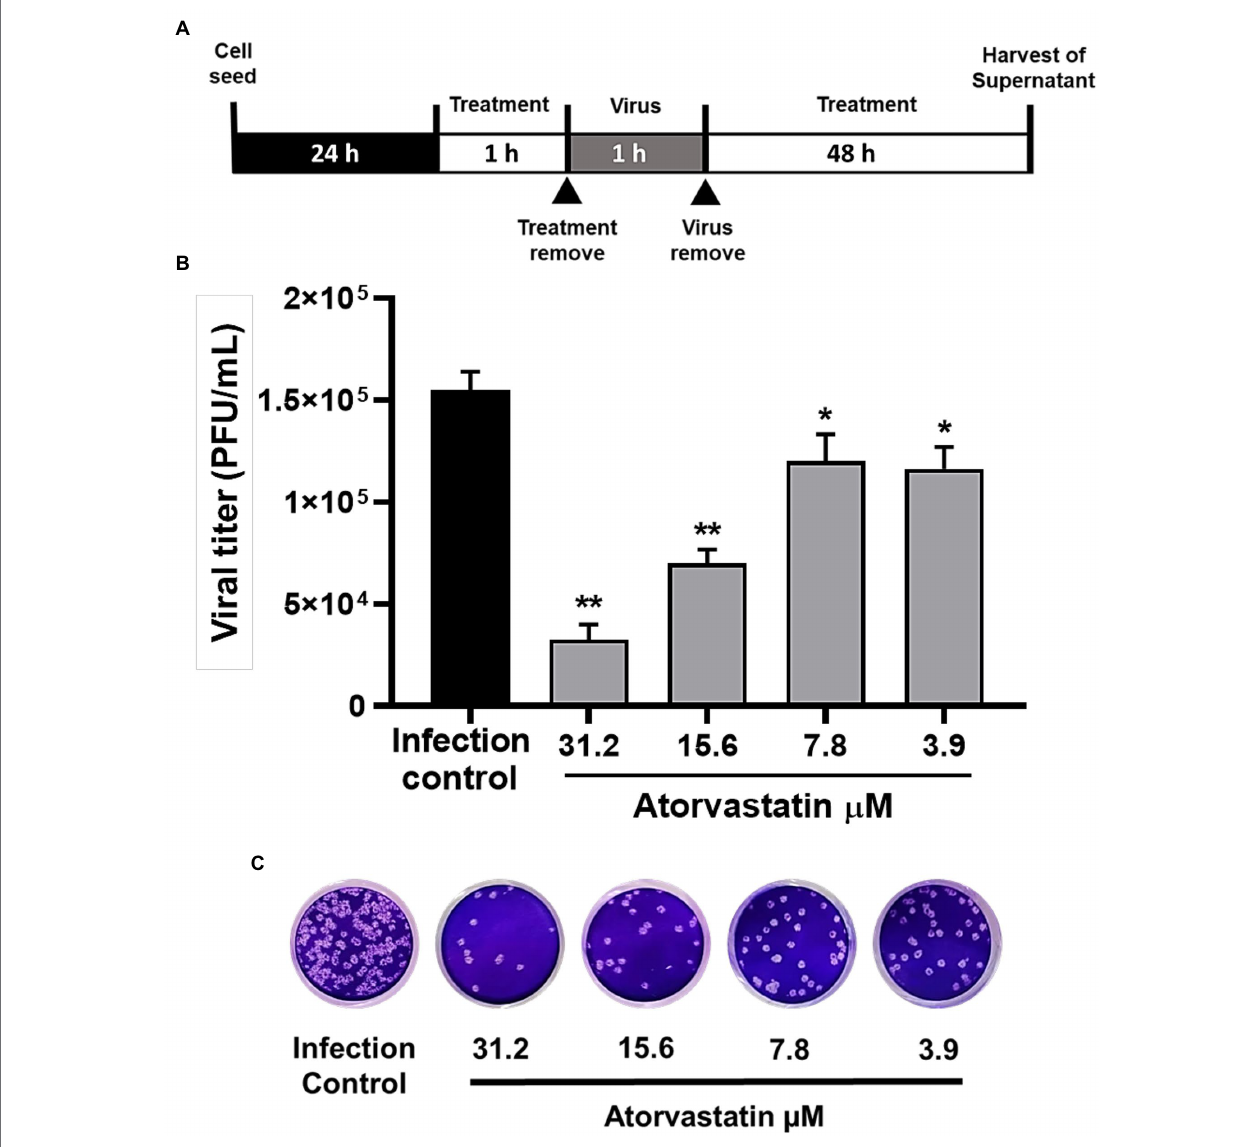
FIGURE 2 | Atorvastatin exhibited an antiviral effect against the SARS-CoV-2 D614G strain in a dose-dependent manner. (A) Schematic representation of the pre- post treatment strategy. (B) Reduction of the D614G strain titer (PFU/ml) in Vero E6 supernatants after pre-post treatment with ATV ( n = 4). Data were presented as